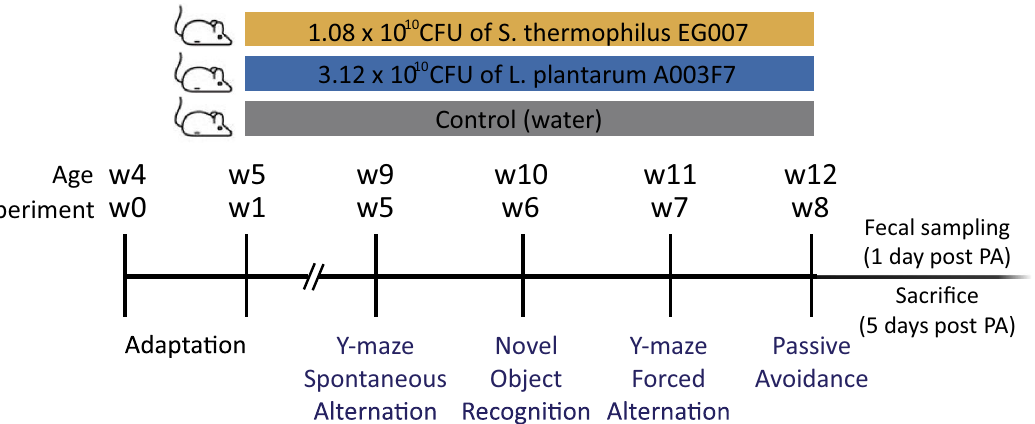
Figure 1. Schematic diagram of study design. Male SPF C57BL/C mice (n = 36) were randomly divided into three groups, and each group was supplemented with S. thermophilus EG007, L. plantarum A003F7, and water (control). From week 5 (nine weeks of age) onward, all mice were subjected to the same series of behavior tests to assess their cognitive performance, the Y-maze test (spontaneous alternation and forced alternation) for spatial memory, the novel object recognition test for nonspatial memory, and the passive avoidance test for long- term associative memory. After 1 day following the last test, fecal samples were collected for gut microbiome community analysis, and all mice were sacrificed after 5